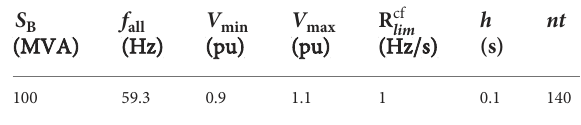
TABLE 5 Other parameters for calculation in 39-bus